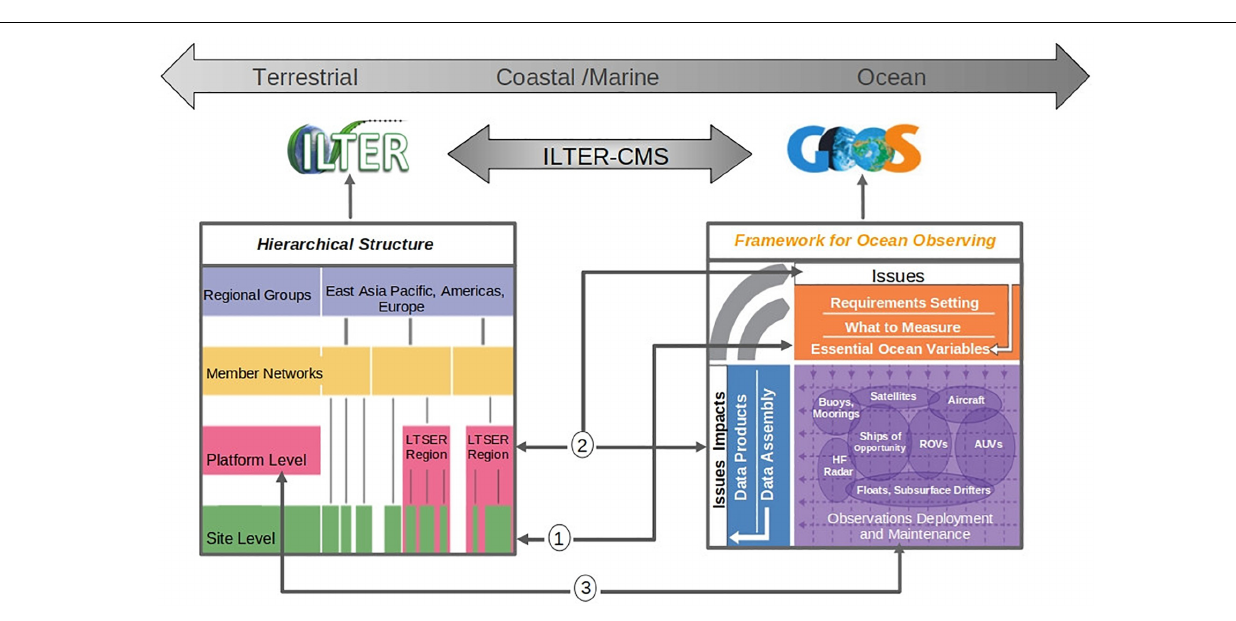
FIGURE 4 | ILTER coastal and marine sites can provide several interaction points between the ILTER structure and the GOOS Framework. ILTER-CMS and GOOS can mutually benefit from setting similar requirements and deciding on what to measure. (1) ILTER sites can provide GOOS with monitoring of Essential Ocean Variables, including many biological variables by classical methods, providing added value to the sensor–based measurements in the GOOS program. (2) The LTSER with social science competence can contribute to define issues and priorities and assess the impact of observations on society. (3) At the platform level the interaction can take place through instrumentation deployment and